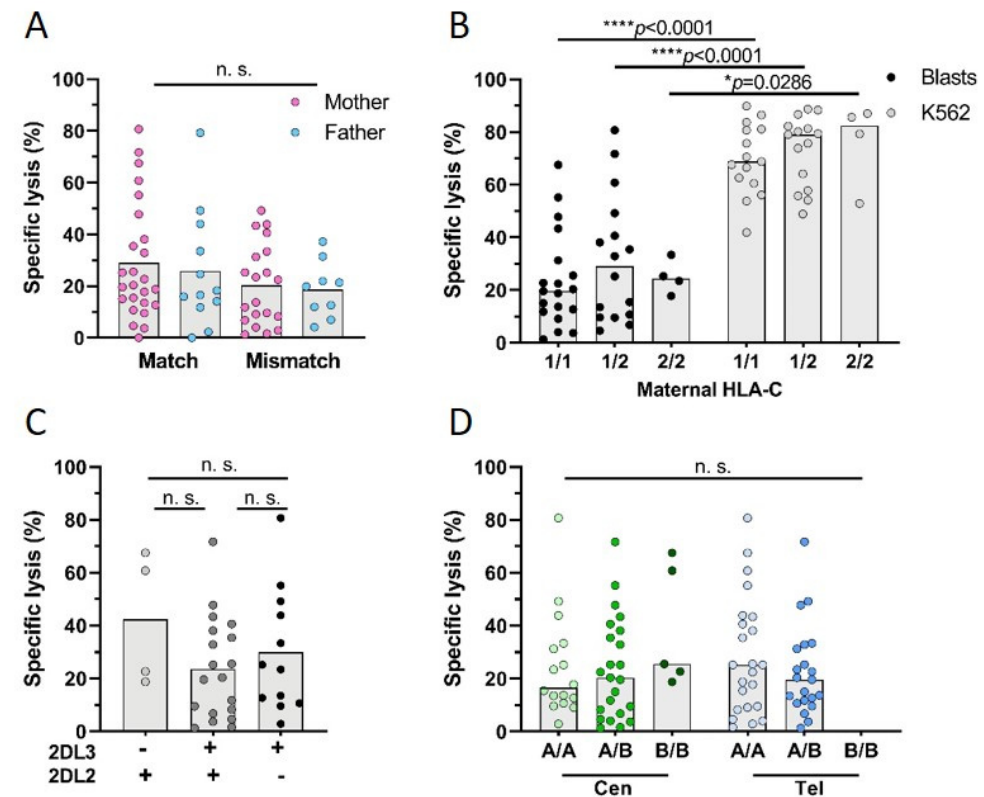
Figure 6. Parental cytotoxicity against filial leukemic blasts: detailed analysis of subgroups. Parental NK cells were isolated and IL-2/IL-15 pre-activated overnight. The next day, their cytotoxicity was analyzed against filial blasts and the control cell line K562 in a FACS-based killing assay. ( A ) Analysis of maternal and paternal NK cell killing of leukemic blasts (E:T 10:1) grouped into HLA-C match or mismatch between child and either mother or father. ( B ) Mothers were grouped depending on their HLA-C genotype and lysis of blasts or K562 was analyzed. Influence of ( C ) maternal KIR2DL2 and KIR2DL3 genotype or ( D ) maternal centromeric (cen) or telomeric (tel) KIR gene motifs on maternal NK cells’ specific lysis of leukemic blasts. Each dot represents one sample, bars show mean of the group. Exact n values are provided in Supplementary Table S2. Statistical analysis was performed using Mann–Whitney test for comparisons of two groups and Kruskal–Wallis test followed by Dunn’s multiple comparison test for more than two groups. Statistical significance * p < 0.05; **** p < 0.0001, n. s. not